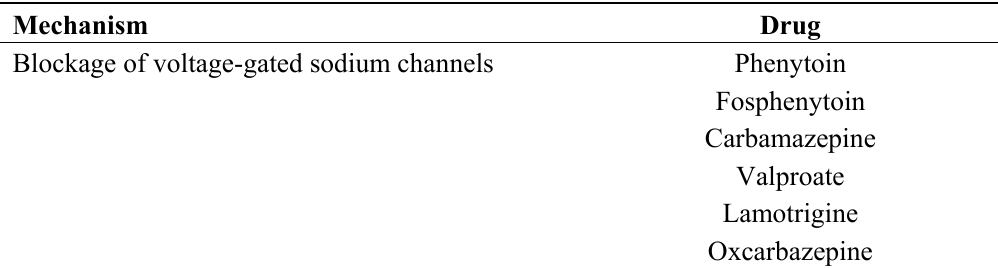
Table 1. The molecular mechanisms of current antiepileptic